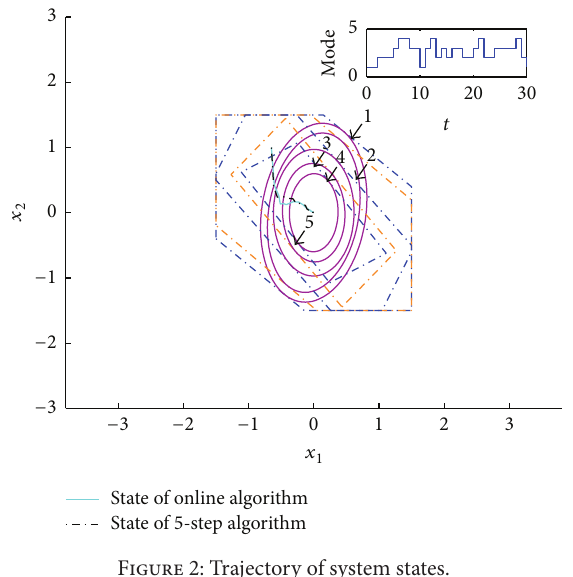
Figure 2: Trajectory of system states. Table 2: 20 times’ average of 30 iterations of system